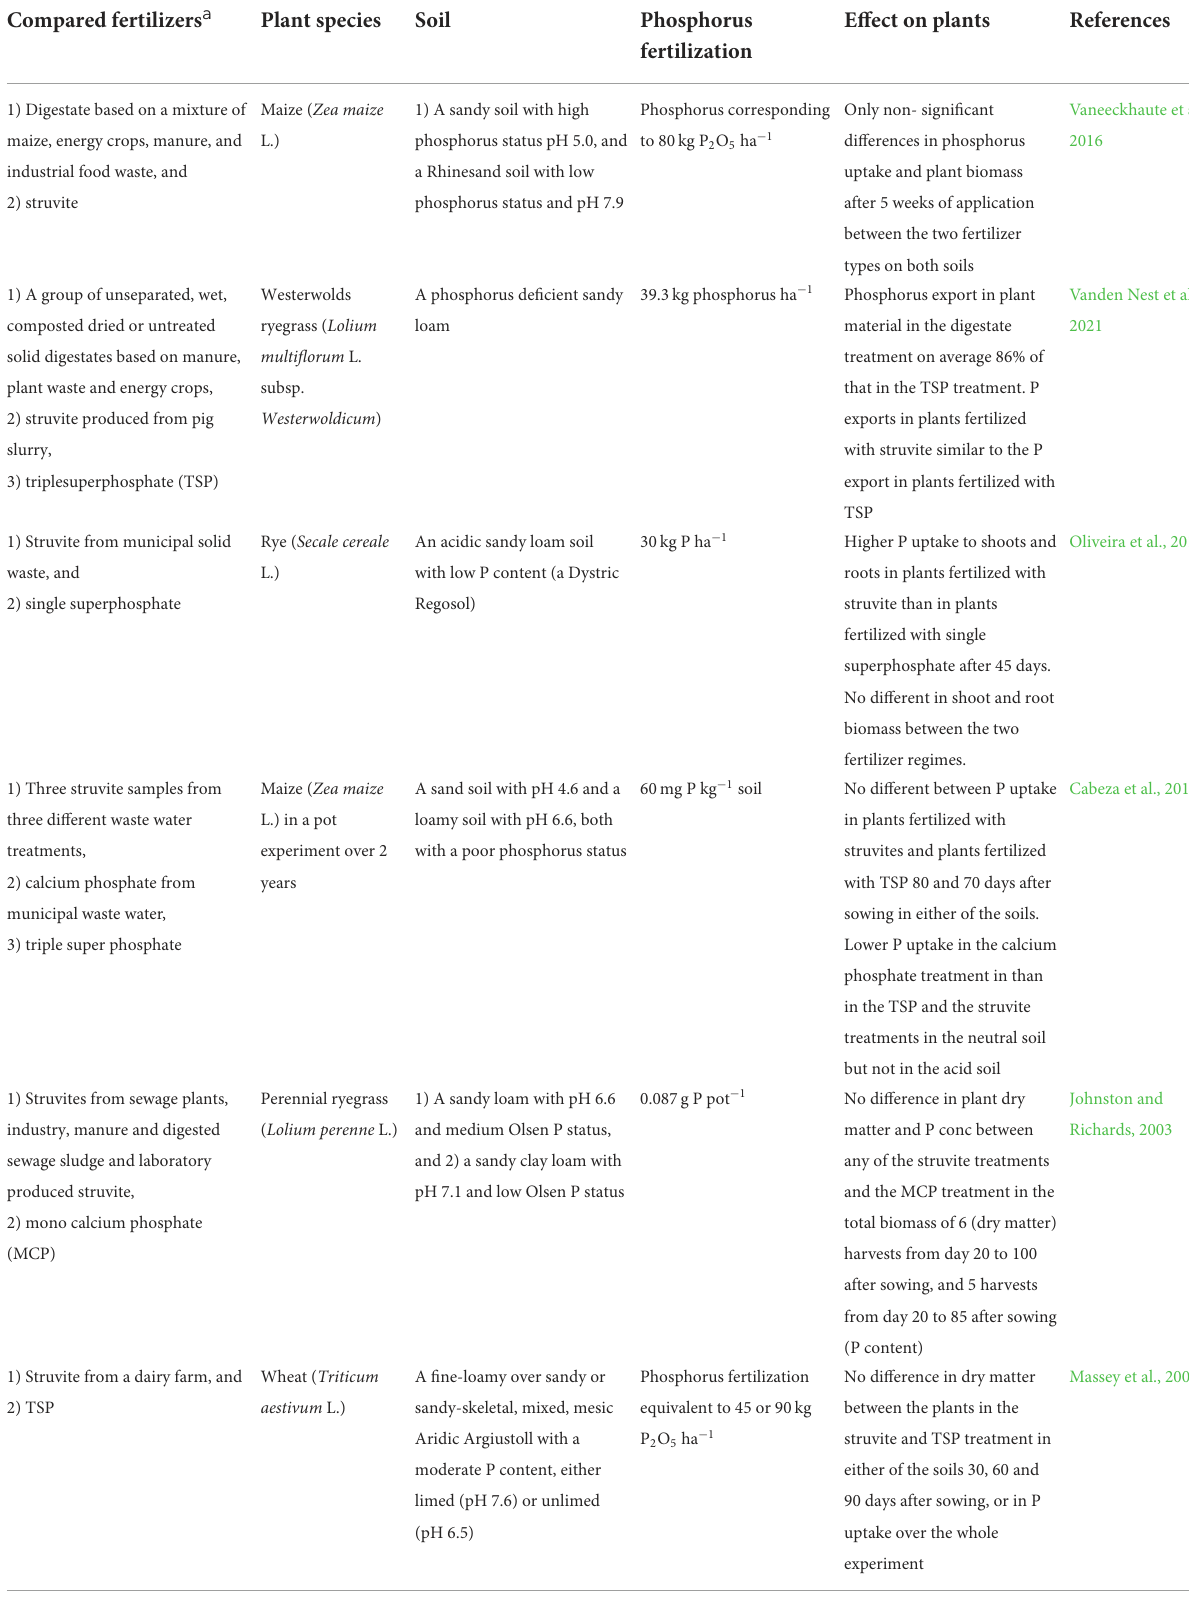
TABLE 3 Agronomic effects of refined wet phase digestate phosphorus fertilizers on plants compared with those from non-refined digestate and traditional mineral phosphorus fertilizers. Compared fertilizers